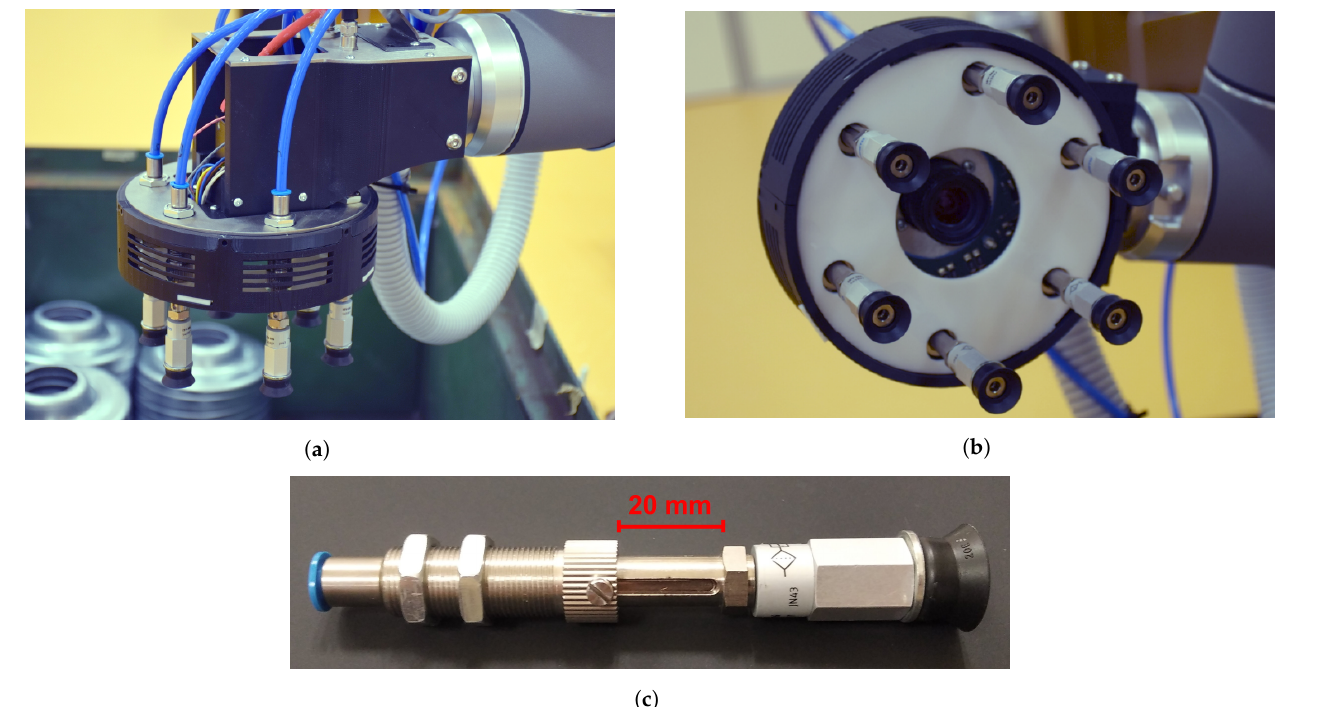
Figure 2. Robotic gripper with suction cups, an integrated lighting system, and a 2D camera positioned at its center. ( a ) Side view. ( b ) Bottom view. ( c ) A detailed view of a suction cup with the integrated spring